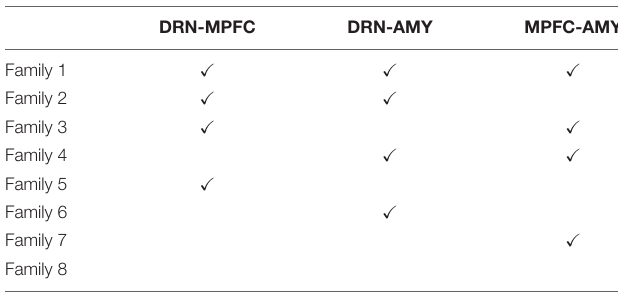
TABLE 1 | Partitioning of model space into eight families based on commonalities in the arrangement of context (“boredom”, “flow”, “overload”)-dependent modulatory effects on connections between DRN and MPFC, and/or DRN and AMY, and/or MPFC and